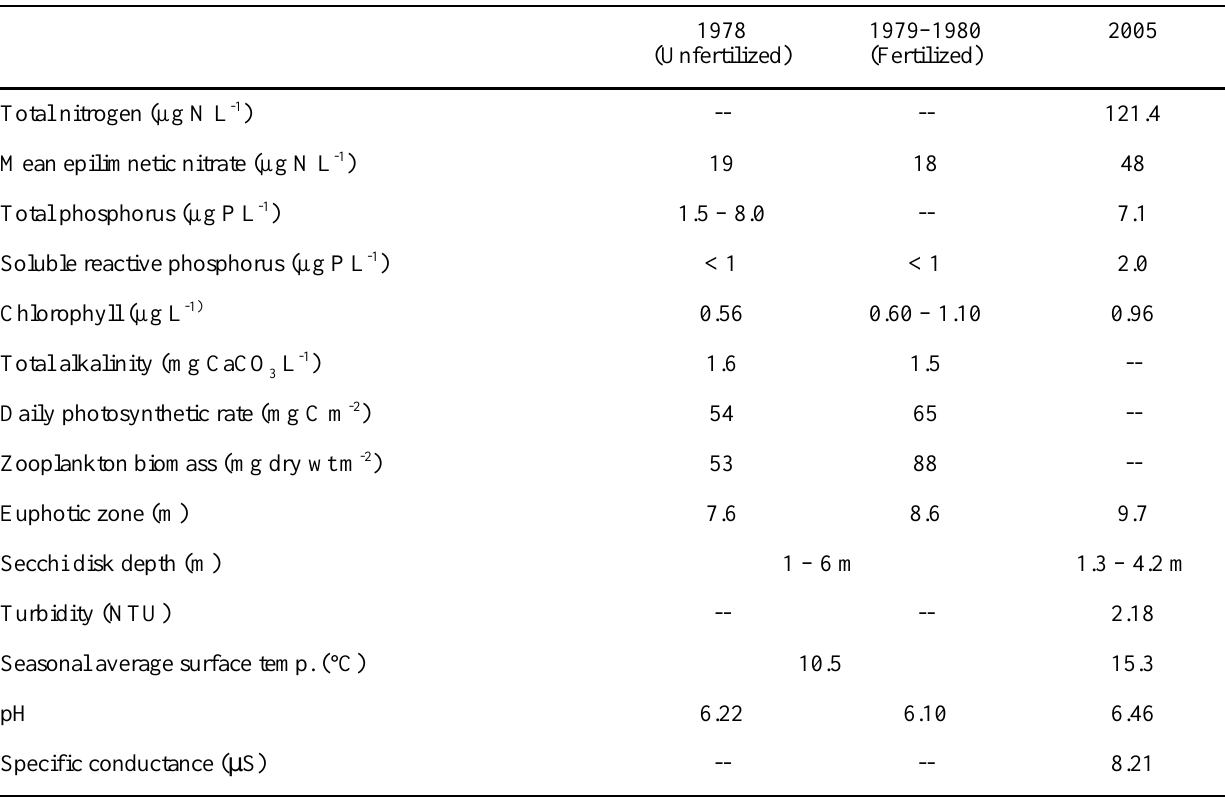
Table 3 . General limnological information for Kitlope Lake. The 1978–1980 data are means from weekly sampling through the growing season taken from Stockner et al. (1993); our 2005 data are means from four sampling events (7/05, 8/02, 8/23, 9/26) for nitrogen (N) and phosphorus (P) and two additional sampling events (5/30, 6/18) for all other variables. Originally published in Hill et al. 2009 by NRC Research